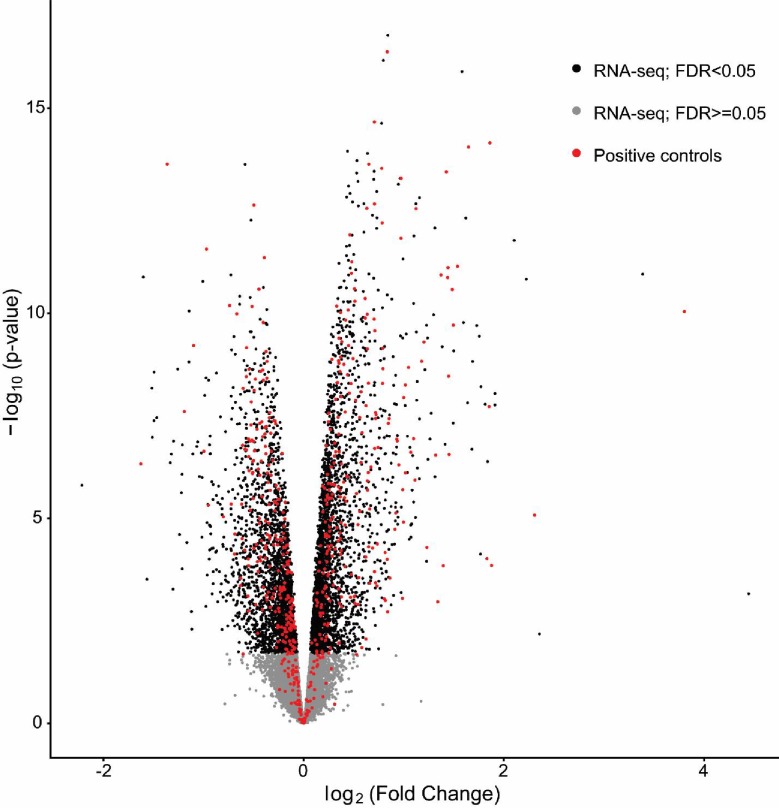
Recovery of positive control genes regulated by sleep deprivation.Volcano plot of differential expression (−log10 P-value versus log2 fold change) caused by sleep deprivation in wild type animals (HC5 vs SD5). Genes with an FDR < 0.05 are highlighted in black. Positive controls (obtained from Gerstner et al., 2016) as described in the Materials and methods) are highlighted in red. Our RNA-seq analysis is able to detect 78% (454) of the 579 positive control genes obtained by microarrays as differentially expressed at FDR < 0.05.